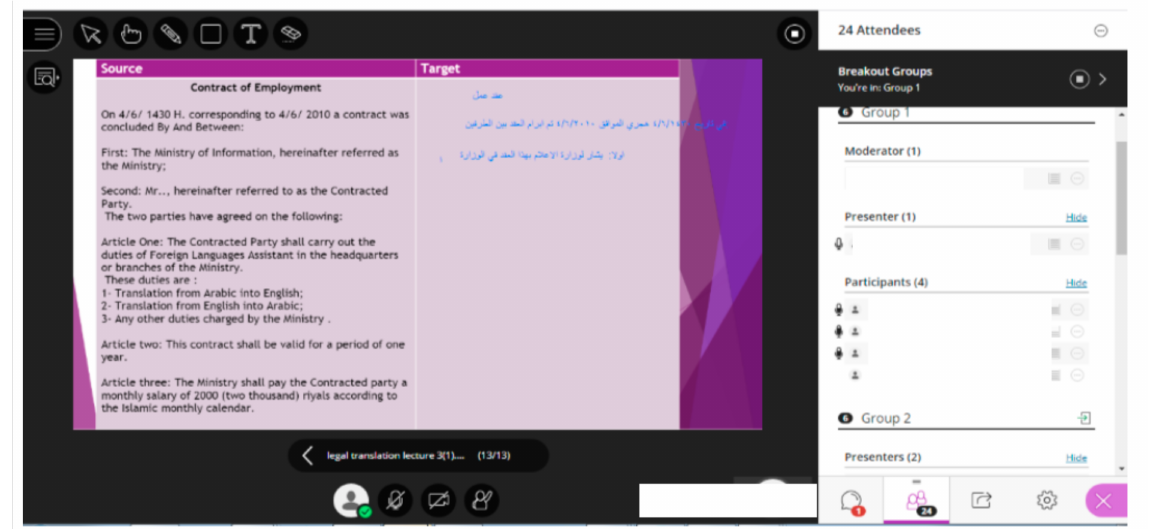
Figure 2. Sample of students’ interaction in one of the